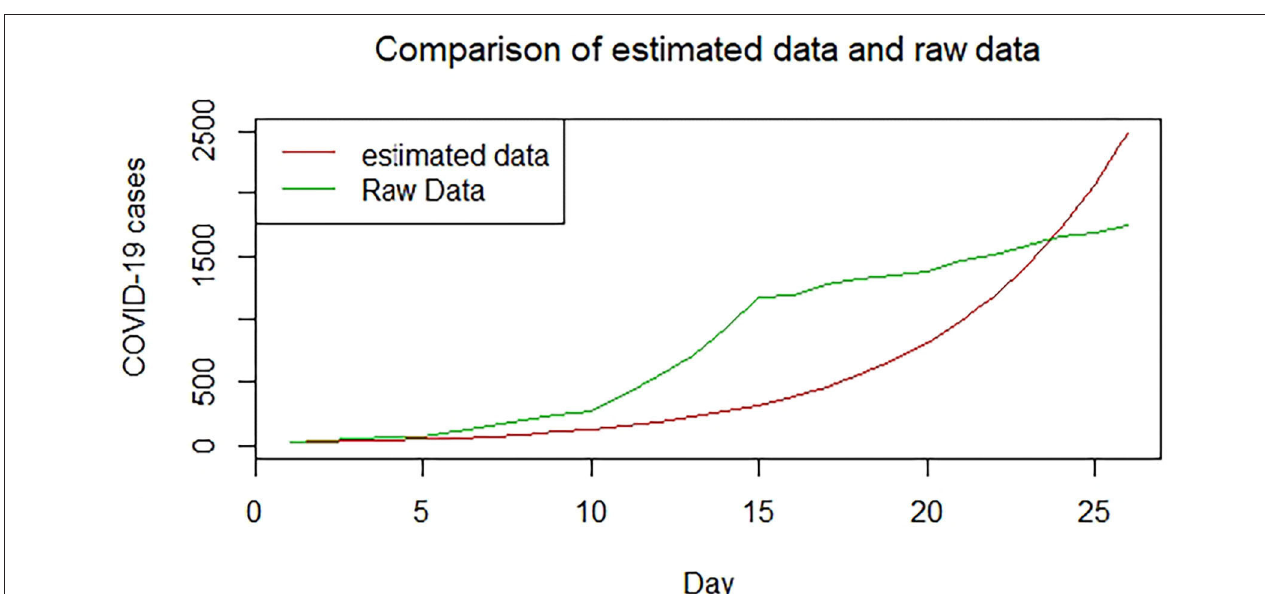
FIGURE 25 | Graph for South